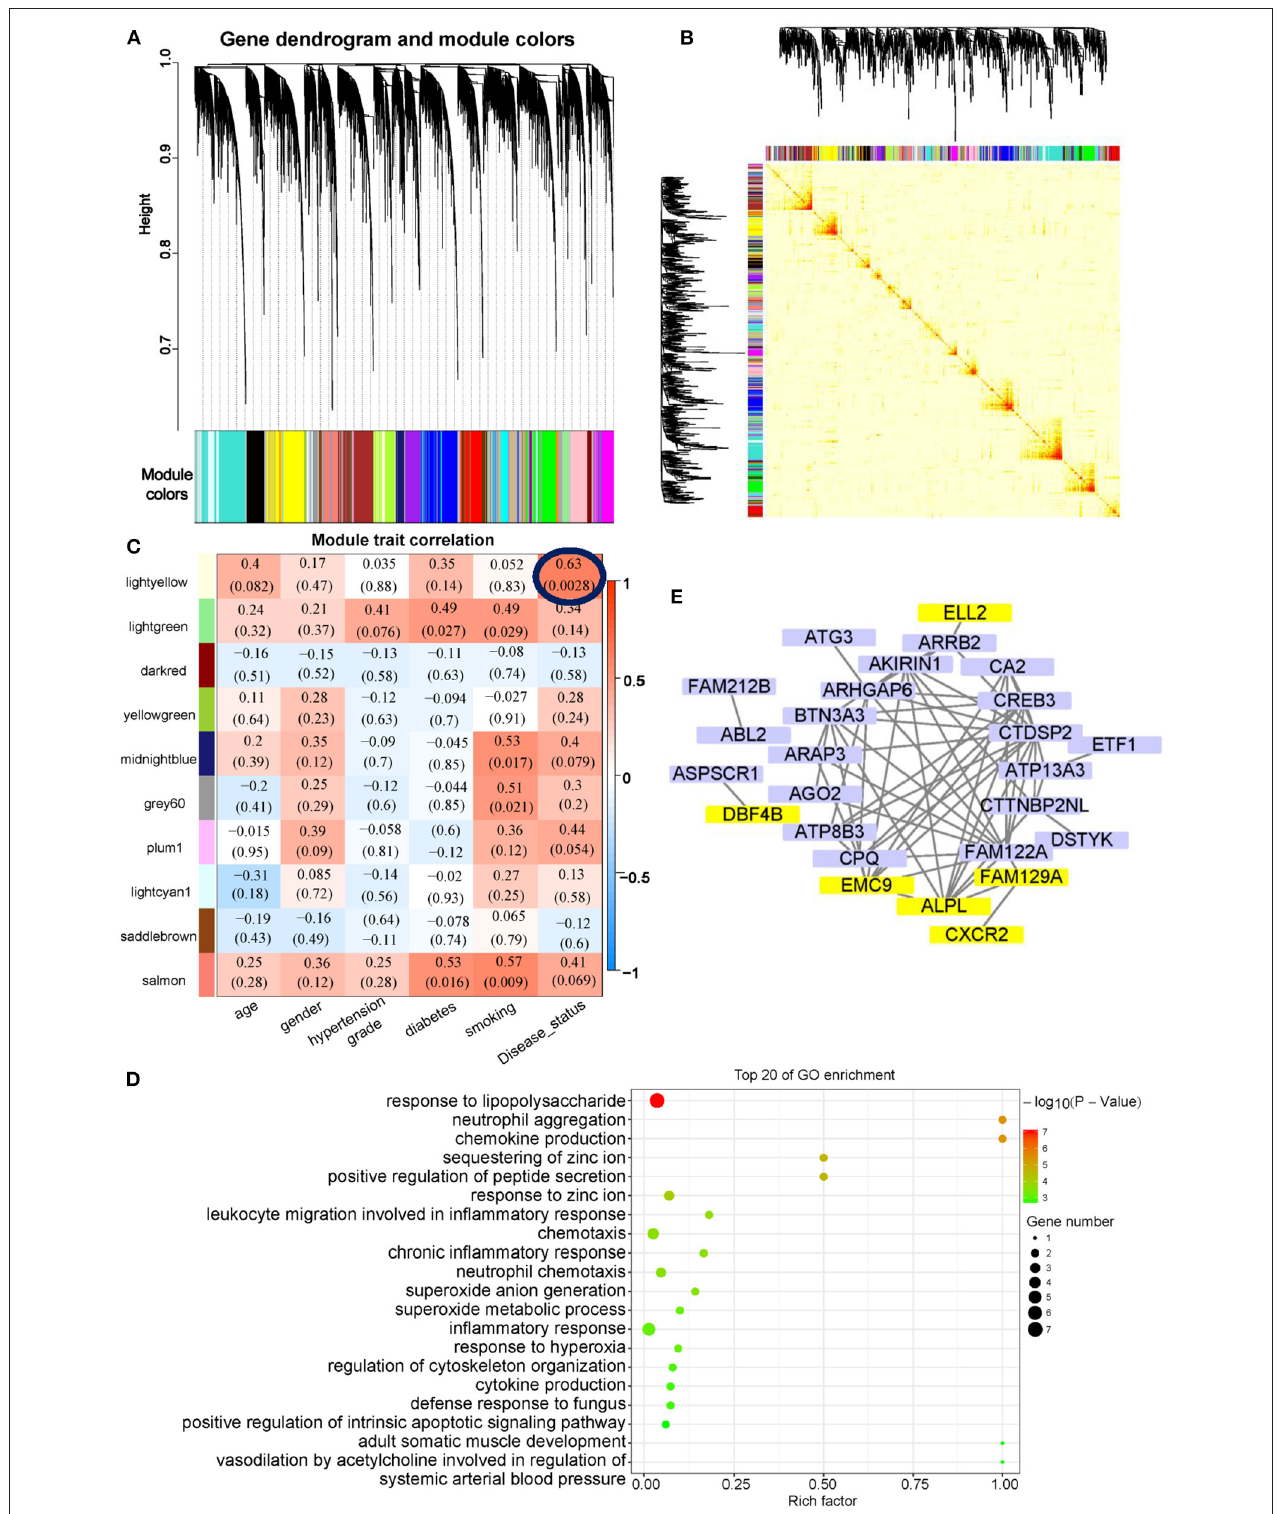
FIGURE 5 | Co-expression network analysis of exosomal mRNAs in AMI. (A) Cluster diagram showing co-expression modules identified by WGCNA. (B) The heat map plot showed the topological overlap matrix (TOM) among all mRNAs. Light color shows low overlap, and red color indicates a higher overlap. The left side and the top side show the gene dendrogram and module assignment. (C) Heatmap of modules-trait relationship. (D) GO enrichment analysis of light-yellow modules. (E) Network visualization of the top 50 exosomal mRNAs of the topological overlap matrix in light-yellow modules. The exosomal mRNA with eigengene connectivity > 0.8 were highlighted in yellow